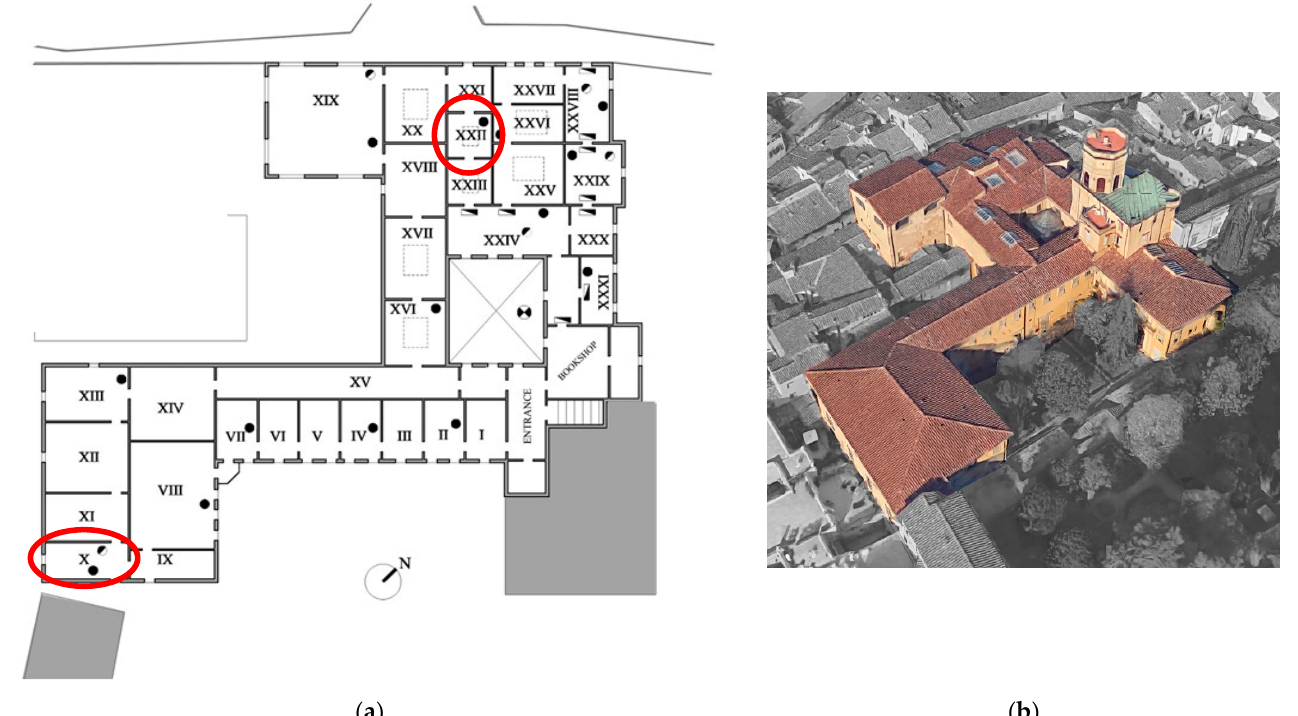
Figure 4. ( a ) Plan with the monitored zones (rooms X and XXII) pointed out and ( b ) view of La Specola museum.